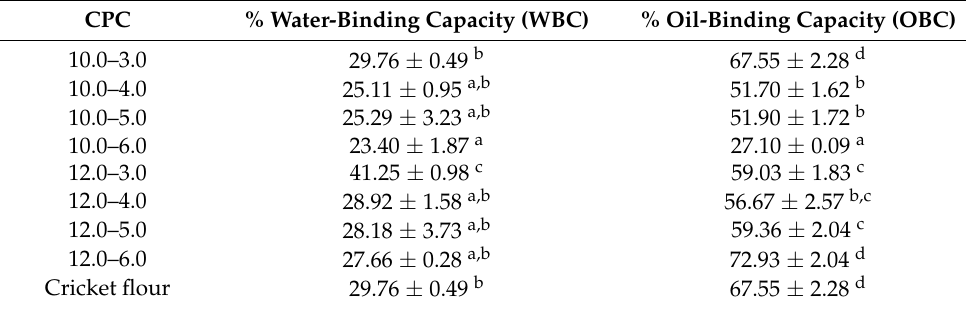
Table 3. % Water-binding capacity (WBC) and oil-binding capacity (OBC) of CPCs.